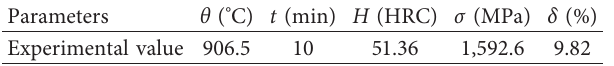
Table 12: Results of testing according to the optimal design. Parameters Experimental value